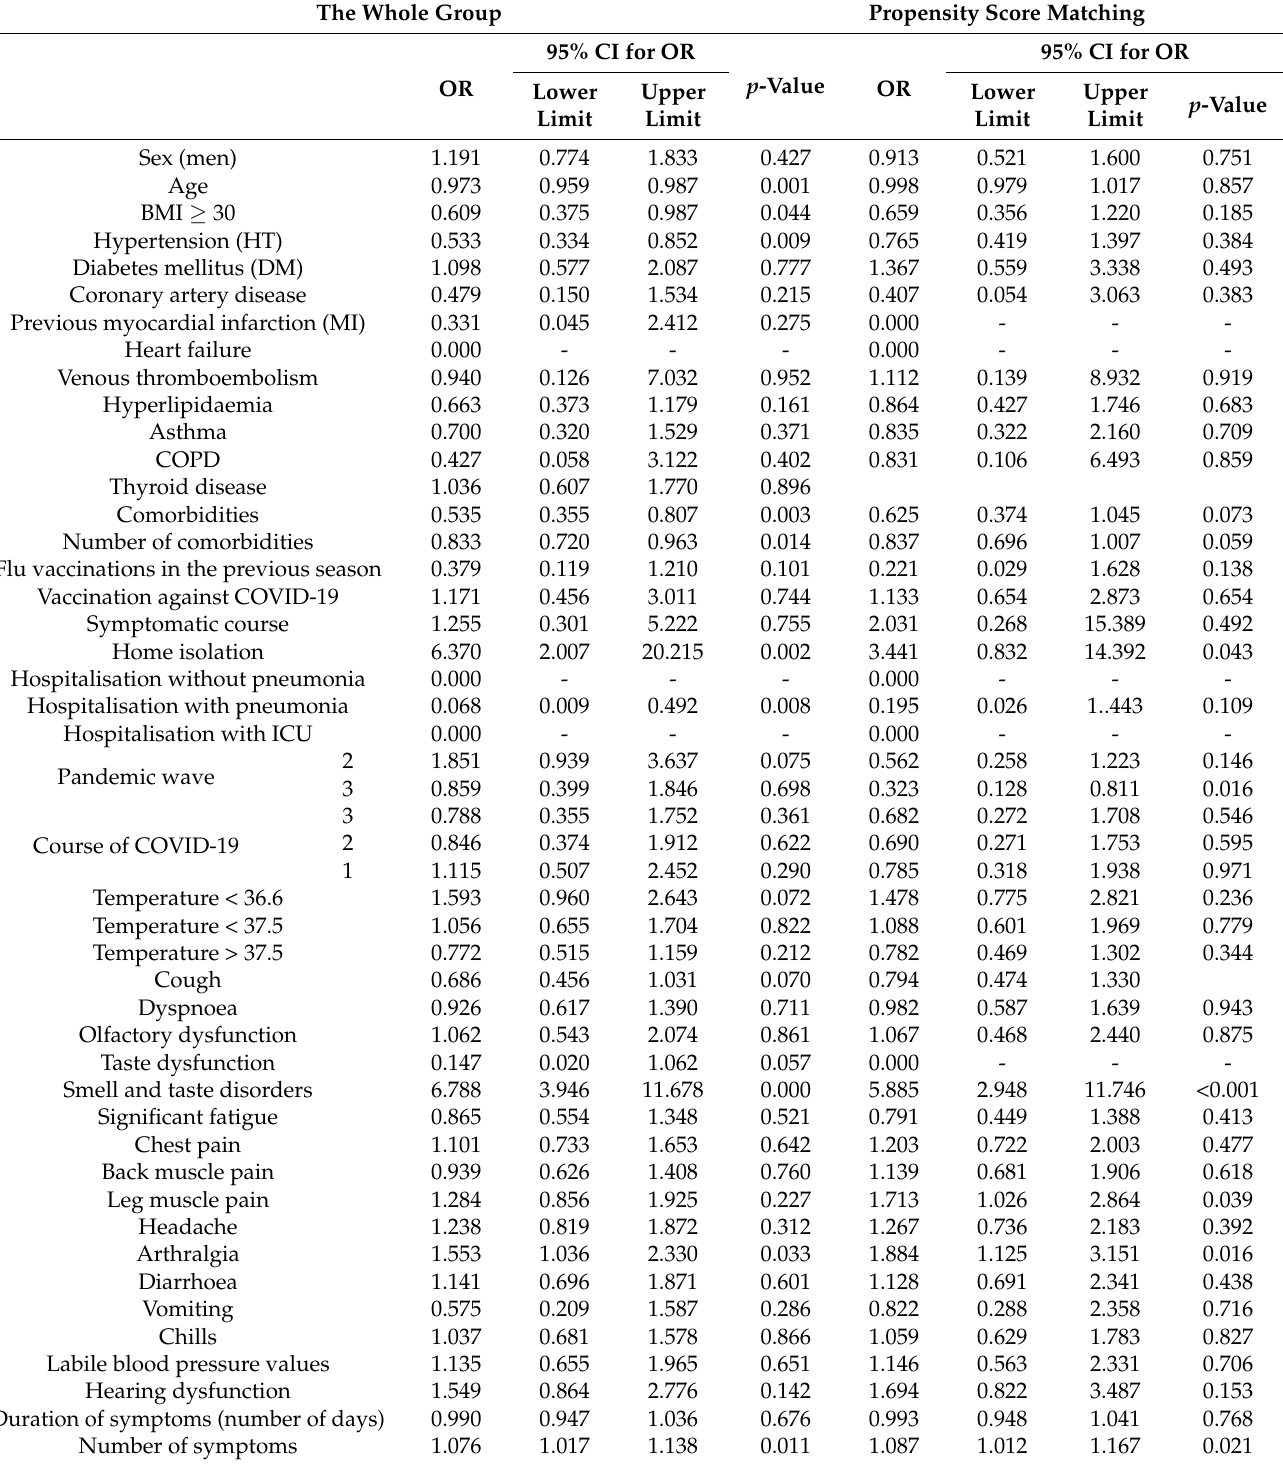
Table 3. Univariate analysis determining the effect of sociodemographic variables, chronic diseases, influenza and COVID-19 vaccination and COVID-19 course on the risk of developing persistent smell and taste disorders. The Whole Group